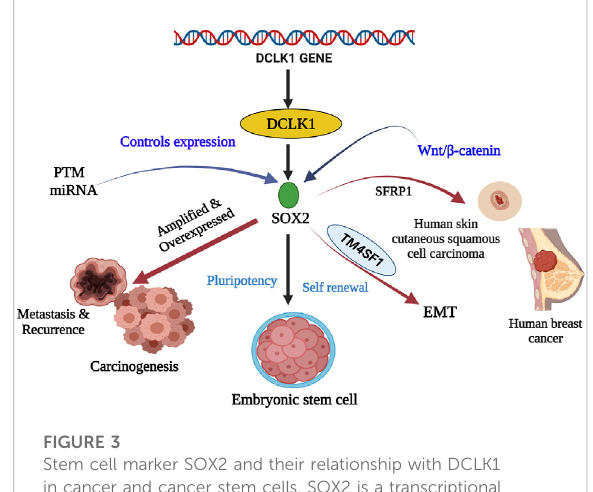
FIGURE 3 Stem cell marker SOX2 and their relationship with DCLK1 in cancer and cancer stem cells. SOX2 is a transcriptional factor that aids in embryogenesis, embryonic stem cells renewal, and pluripotency. Its expression is controlled by PTM and miRNA. Under regular conditions, they maintain pluripotency and self-renewal. However, under ampli fi ed and overexpressed conditions SOX2 upregulates DCLK1 expression leading to metastasis, recurrence, and carcinogenesis. SOX2, in the presence of SFRP1 and TM4SF1, has been observed to cause skin carcinoma, breast cancer, and